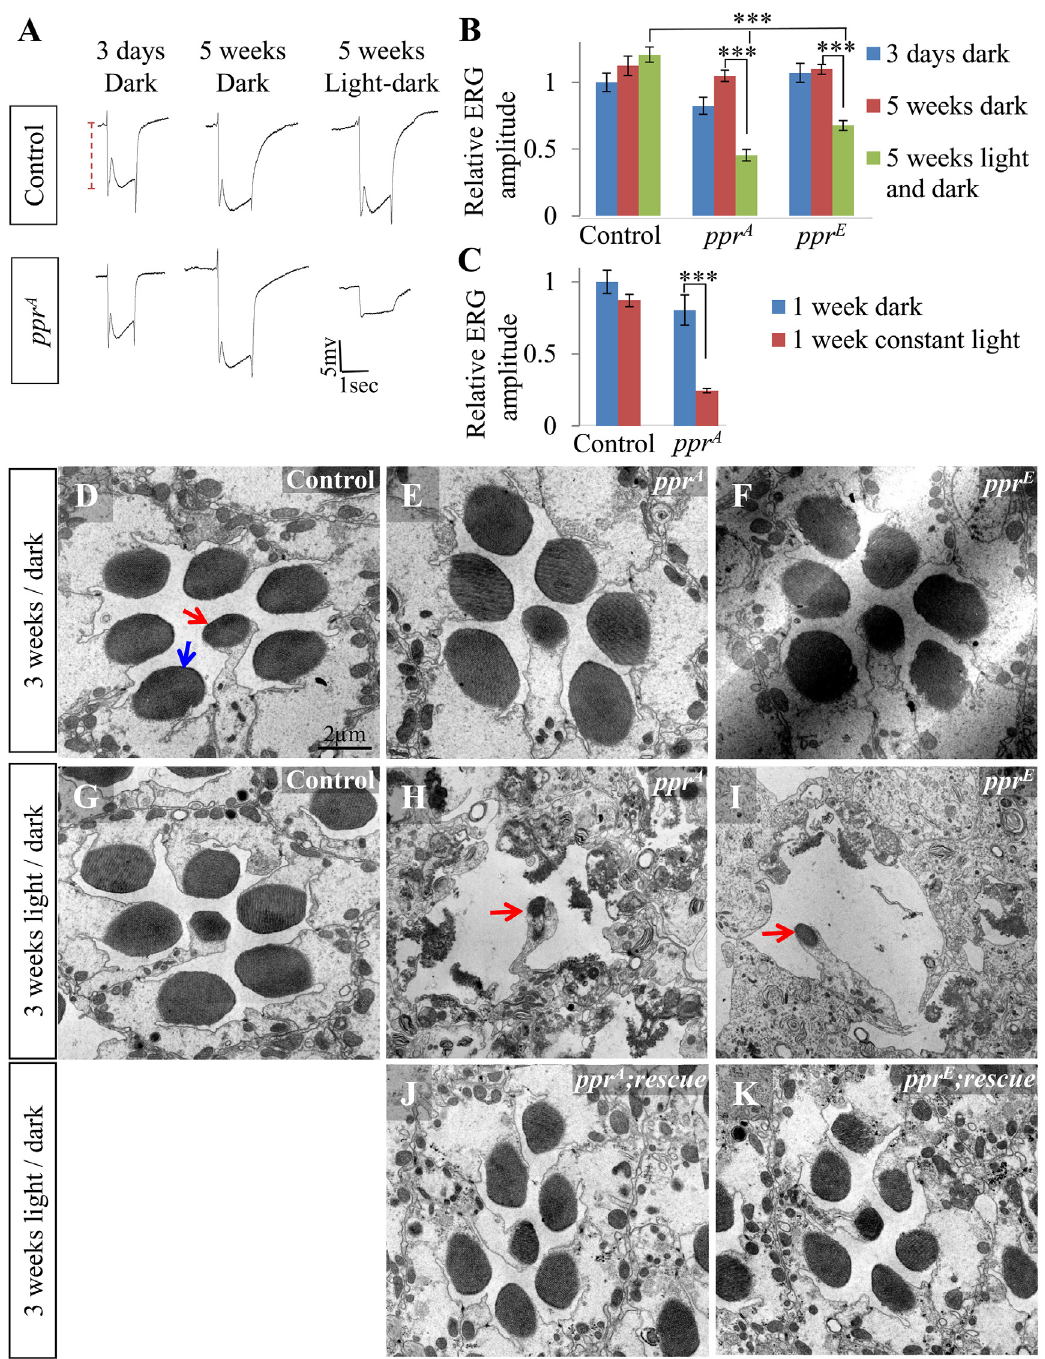
Fig 2. PR degeneration due to ppr loss of function is light-dependent. (A) ERG traces from control and ppr A mutant eye clones. Flies were raised either in constant dark for three days, constant dark for five weeks, or a 12 h light/dark cycle for five weeks. Dashed line indicates ERG amplitude. (B) Quantification of ERG amplitudes for experiment shown in (A). (C) Quantification of the ERG amplitude of control and ppr A mutant eye clones of flies that were grown in dark or constant light for one week. Error bars represent mean ± standard error of the mean (SEM); statistical significance was determined using a two-tailed Student ’ s t test ( p -value: *** < 0.001). (D – K) Transmission Electron Microscopy (TEM) of a single ommatidium from control (D, G), ppr A (E, H), ppr E (F, I), ppr A ; genomic rescue (J) and ppr E ; genomic rescue (K). Flies were raised in the dark (D – F) or in a 12 h light/dark cycle for three weeks (G – K). The dark structures indicated by arrows in (D) are rhabdomeres. The red arrow specifically indicates R7 or R8 rhabdomeres, which do not degenerate in mutants exposed to light (H, I). Light intensity during light periods was ~1,800